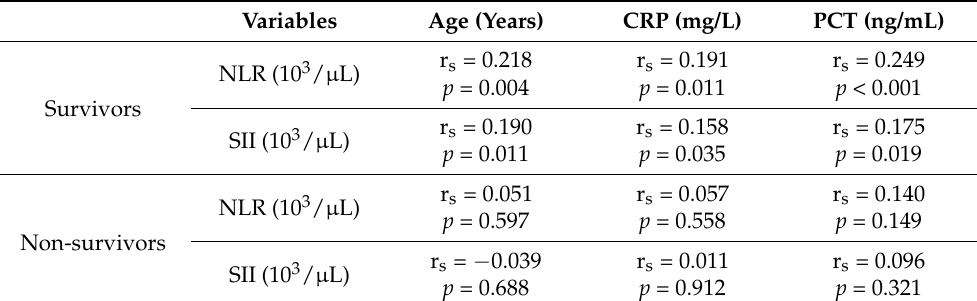
Table 4. The relationships of the NRL and SII with the age and other inflammation markers.